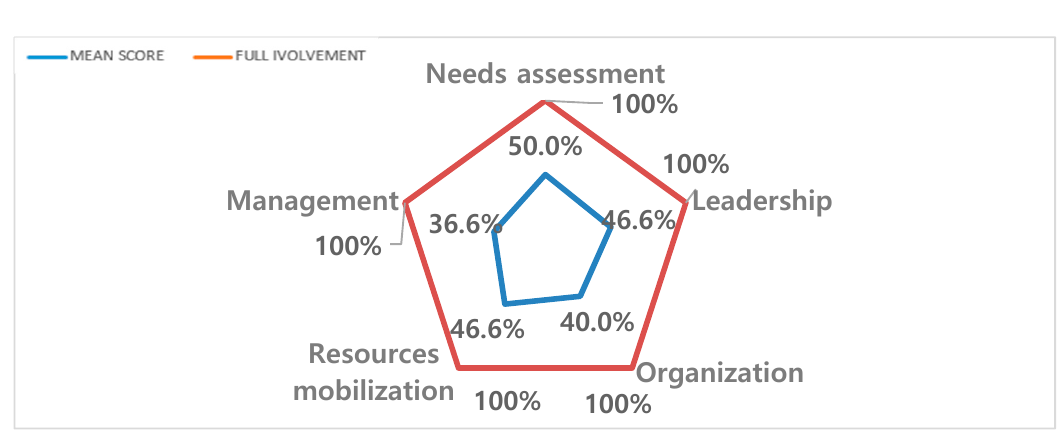
Table 2. Interventions targeting more than one category of participants.